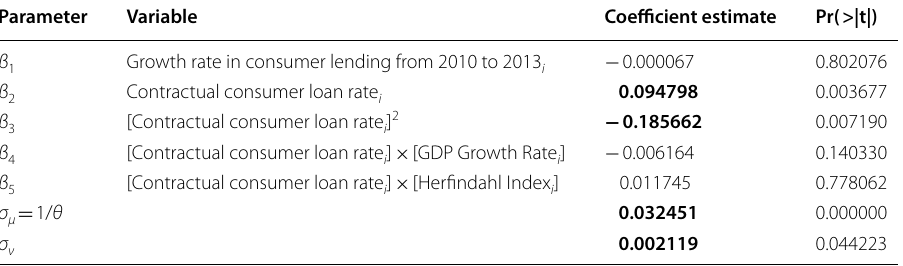
The data set includes LendingClub and 654 top-tier bank holding companies at the end of 2013 with plausible values of nonperforming unsecured consumer loans and total loans exceeding 10 percent of assets Skewness and D’Agostino skewness test of OLS residuals ( ∼ N ( 0,1 ) asymptotically ) : skewness = 4.3289 (> 0 ) ⇒ positively skewed test statistic = 20.6471 with p -value < 2.2E 16 ⇒ positively skewed with statistical significance. − Histogram and density of OLS residuals in the relative frequency scale appear in Appendix 4 Likelihood ratio test of H 0 : σ 2 µ = 0 vs. H 1 : σ 2 µ > 0 (asymptotically distributed as 50:50 mixture of χ 2 ( 1 ) and χ 2 ( 0 ) ): test statistic = 753.2751 with p -value < 2.2E